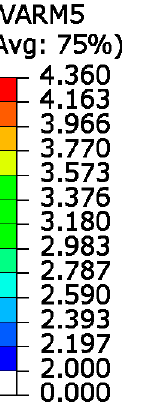
Figure 15. The contour of the VGI.